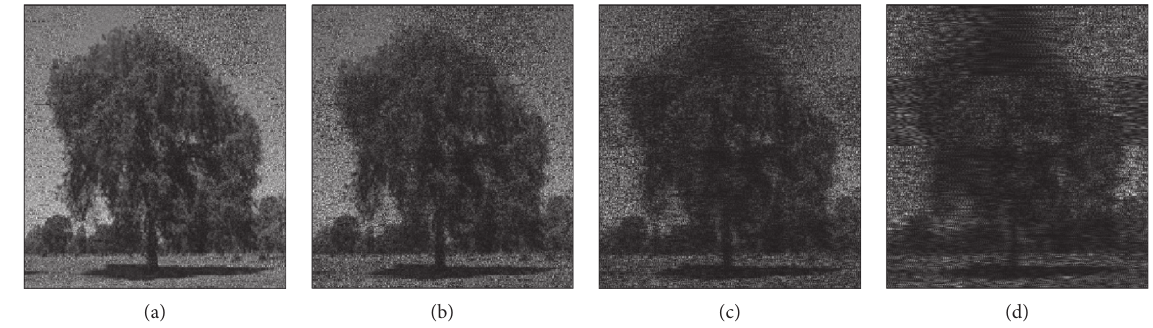
Figure 12: Retrieved image for (a) k � 0.1; (b) k � 0.5; (c) k � 1; (d) k �